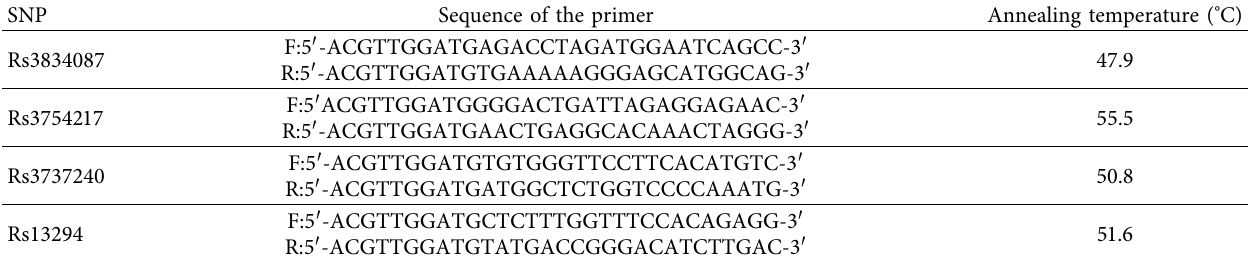
Figure 1: Location of the extracellular matrix 1 gene and single nucleotide polymorphisms. Table 1: Primer sequences and reaction conditions for genotyping ECM1 polymorphisms.